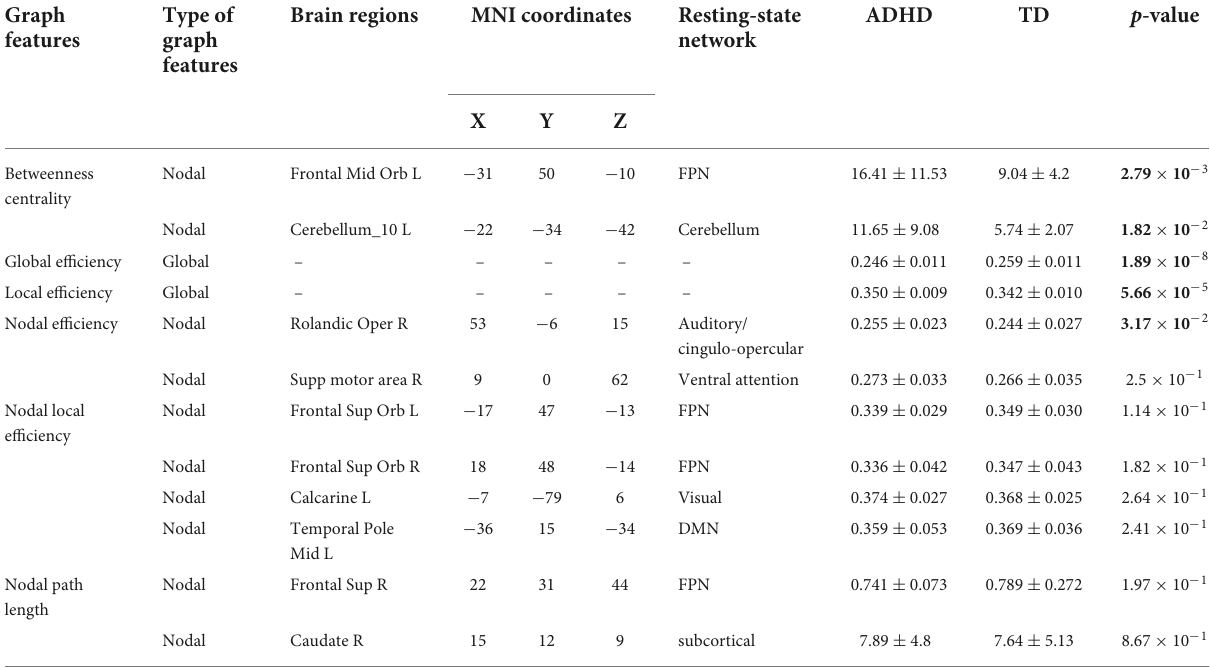
TABLE 4 Mean, standard deviation, and statistical comparison of top 12 graph features selected by RFE in children with ADHD and TD groups. Graph